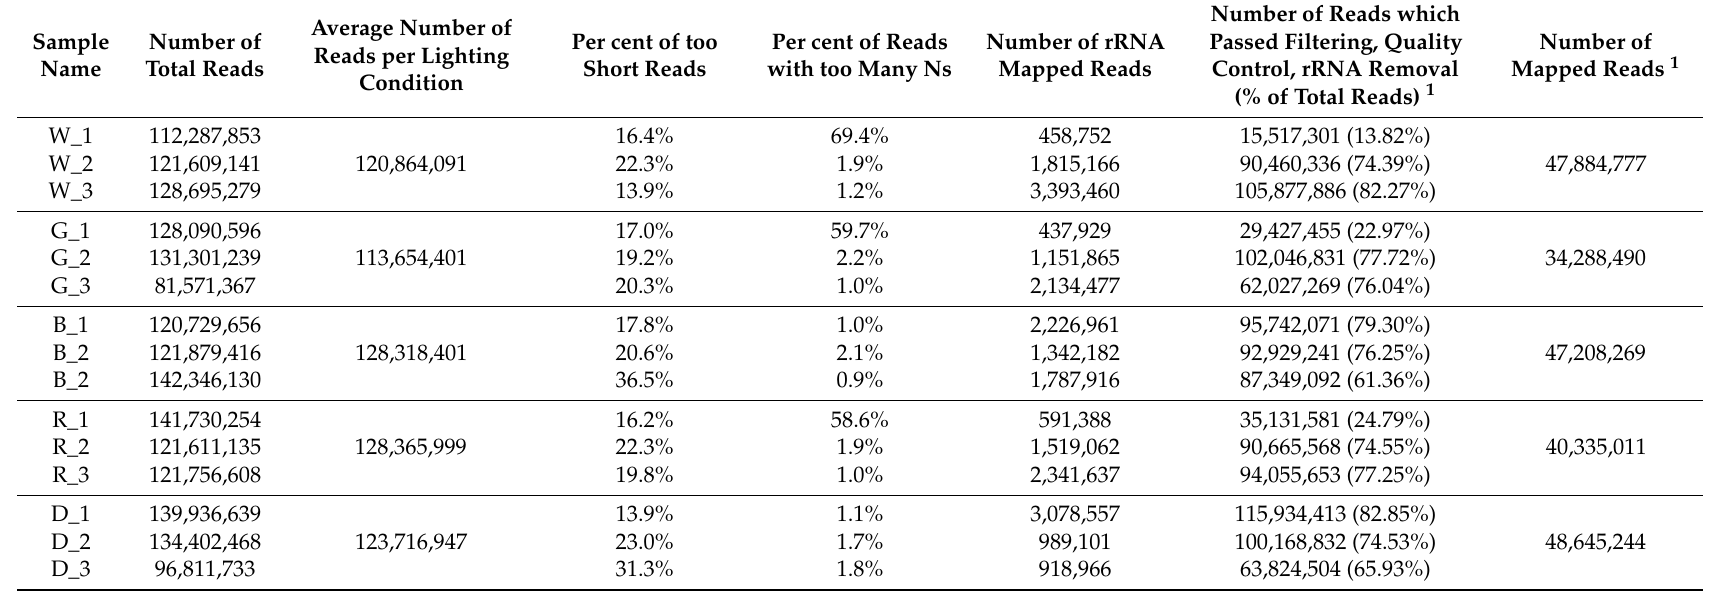
Table 1. Filtering and processing of individual cDNA replicate sample reads of C. unicolor grown on ash sawdust in the following lighting variants: white (W), green (G), blue (B), and red (R) light and darkness (D) as a